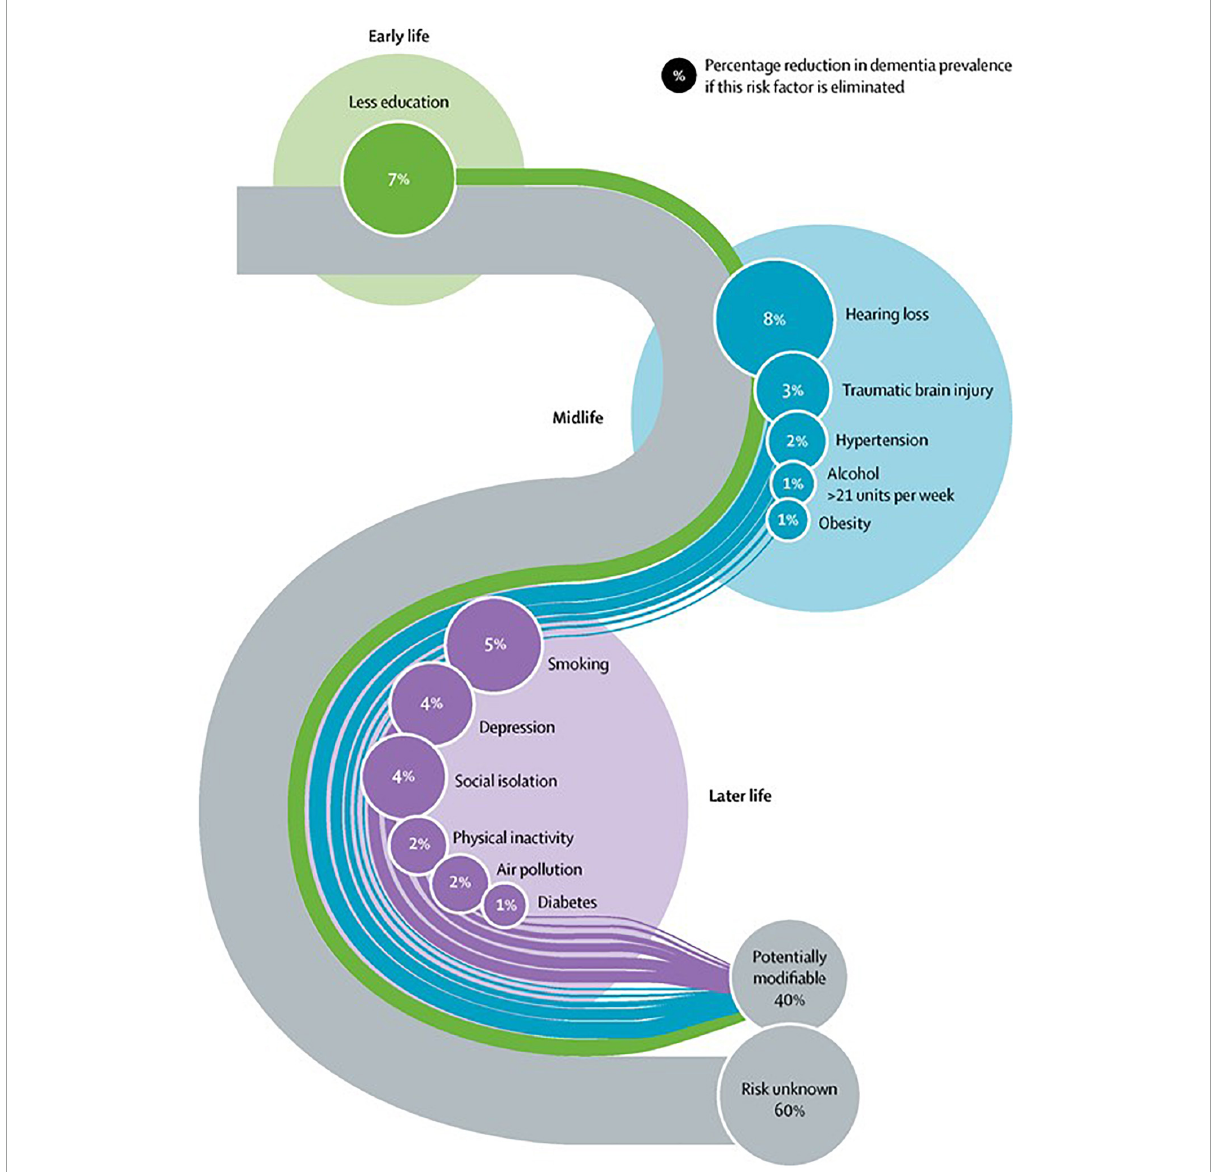
FIGURE1 Reprinted from the Lancet, Vol. 396, Gill Livingston, Jonathan Huntley, Andrew Sommerlad, David Ames, Clive Ballard, Sube Banerjee, Carol Brayne, Alistair Burns, Jiska Cohen-Mansfield, Claudia Cooper, Sergi G. Costafreda, Amit Dias, Nick Fox, Laura N. Gitlin, Robert Howard, Helen C. Kales, Mika Kivimäki et al. Dementia prevention, intervention, and care: 2020 report of the Lancet Commission, Pages 413–446, Copyright (2020), with permission from